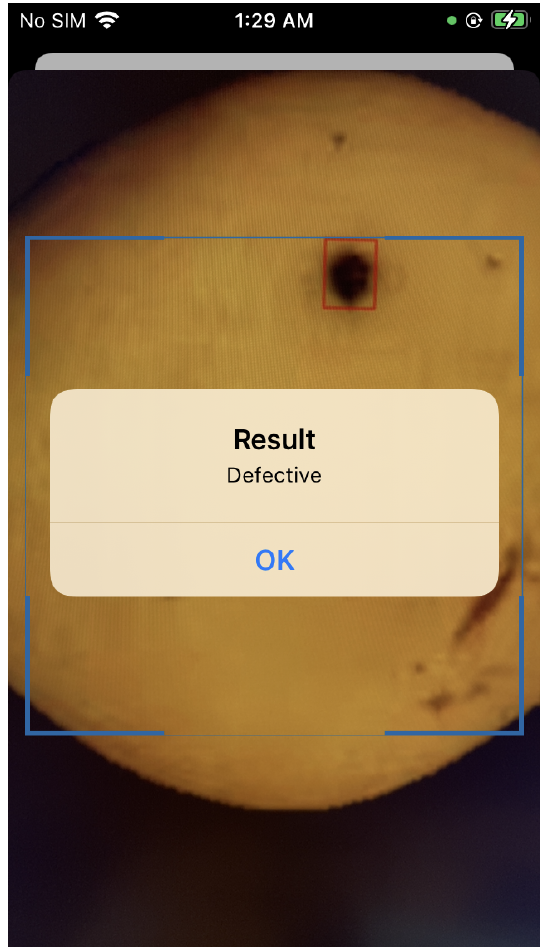
Figure 15. Screenshot on iPhone